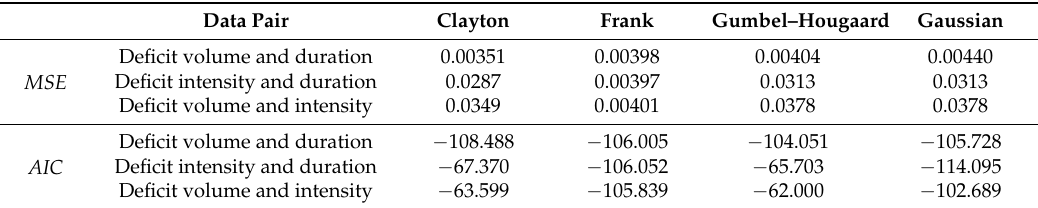
Table 5. The MSE s and AIC s calculated for three bivariate data pairs of the water deficit events observed at the Namgang